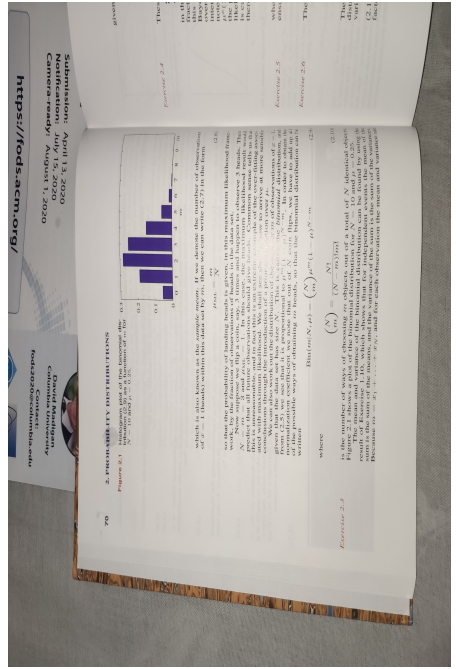
Figure 6. Input image from the use case. The bar chart must be located and